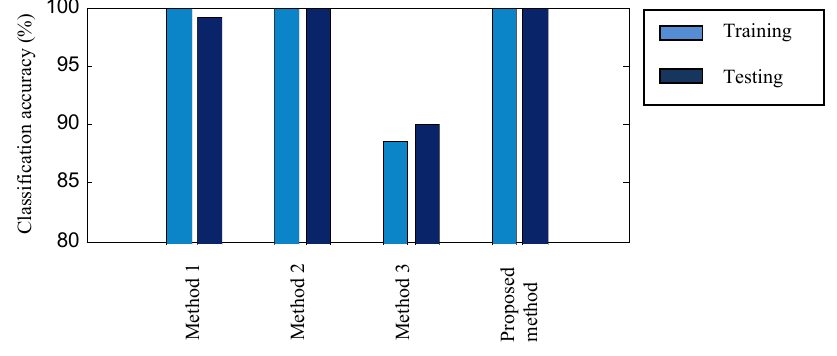
Figure 6. Accuracy comparison between Methods 1~3 and the proposed method for Case 1.